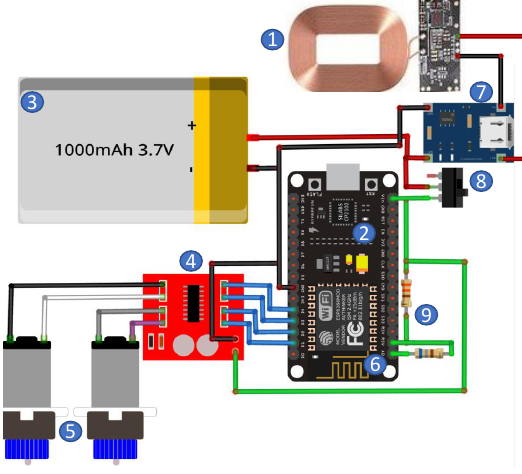
Figure 7. Electronic architecture of